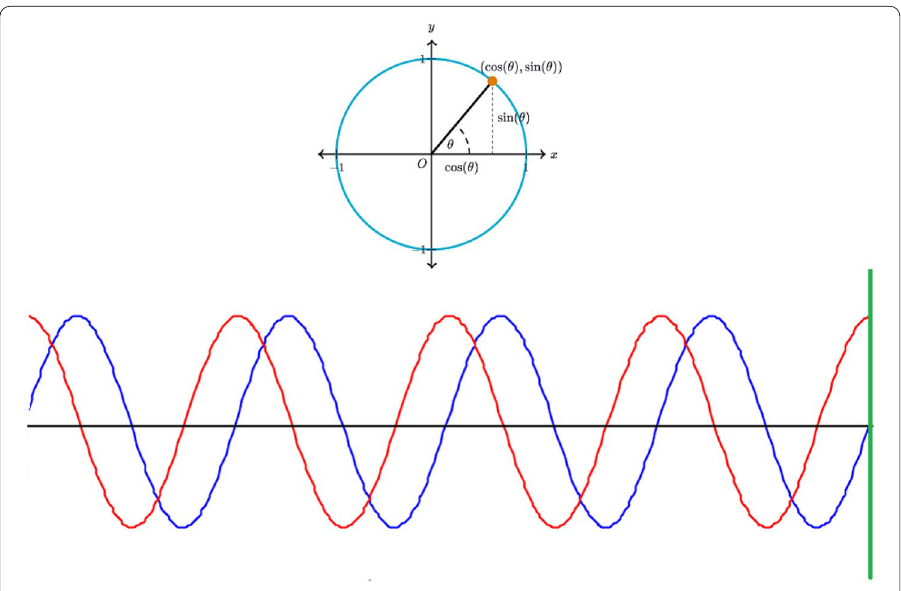
Initial status of power generation